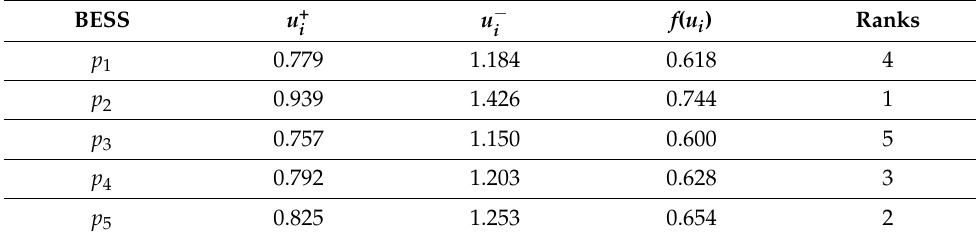
Table A8. The utility degrees and CUF of each option for prioritizing the BESSs.